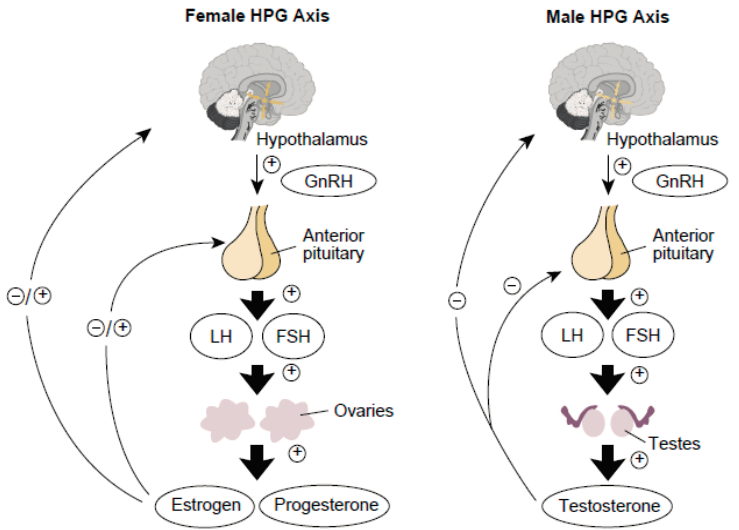
Figure 5. Schematic representation of the hypothalamic–pituitary–gonadal (HPG)